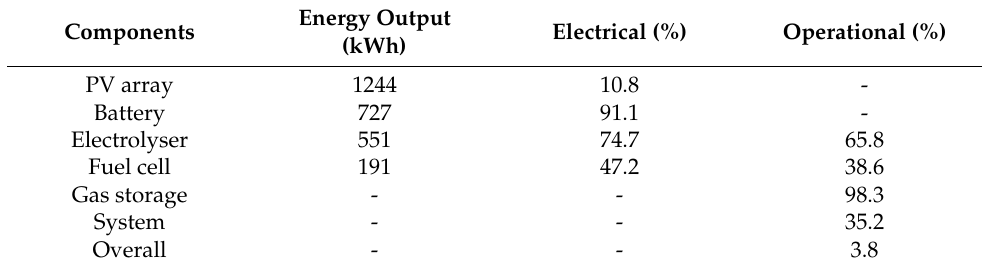
Table 4. Efficiencies of the IPVFC system for one year